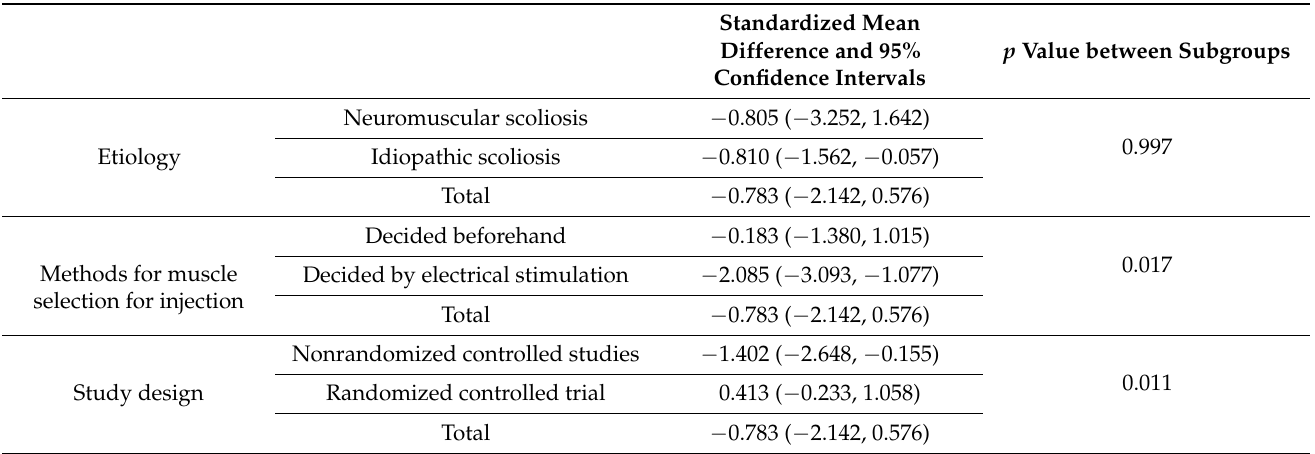
Table 3. Results of subgroup analysis.